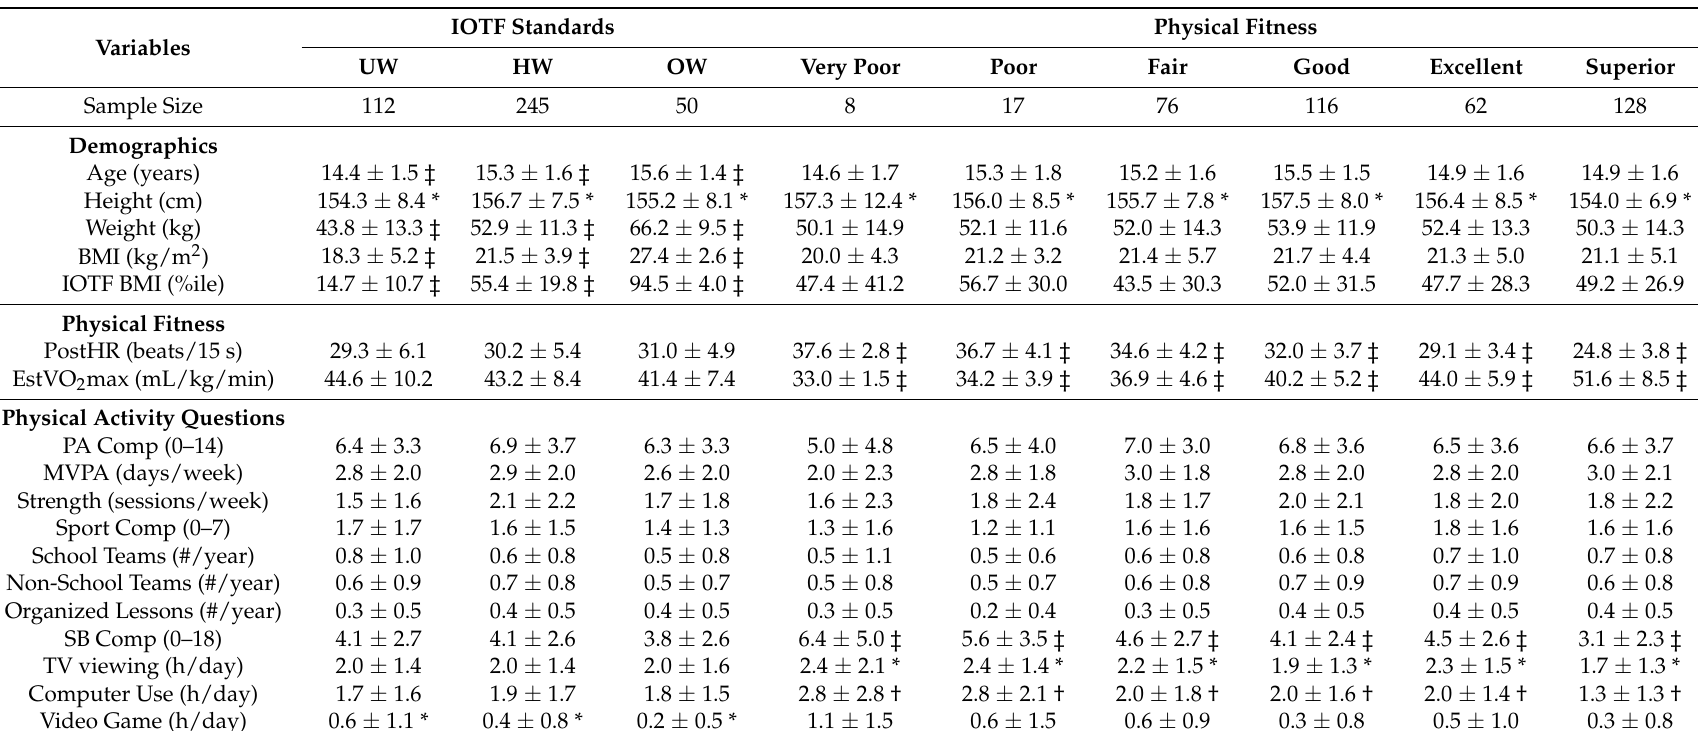
Table 2. Participant characteristics by weight status and physical fitness classification. Means ±